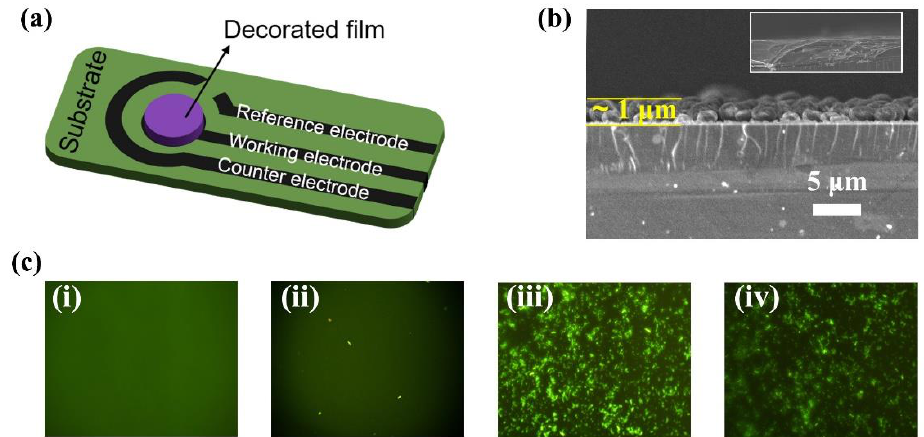
Figure 3. ( a ) Schematic diagram of the structure of modified carbon screen-printed electrode; ( b ) SEM images of the intersecting surface; ( c ) fluorescence images of ( i ) bare carbon working electrode, ( ii ) bare carbon working electrode/FAM aptamer, ( iii ) ZM modified carbon working electrode/FAM aptamer and ( iv ) ZM modified carbon working electrode/FAM aptamer/ATP.